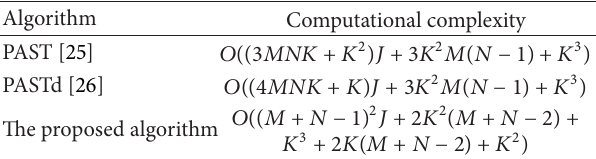
Table 1: Complexity comparison. Algorithm